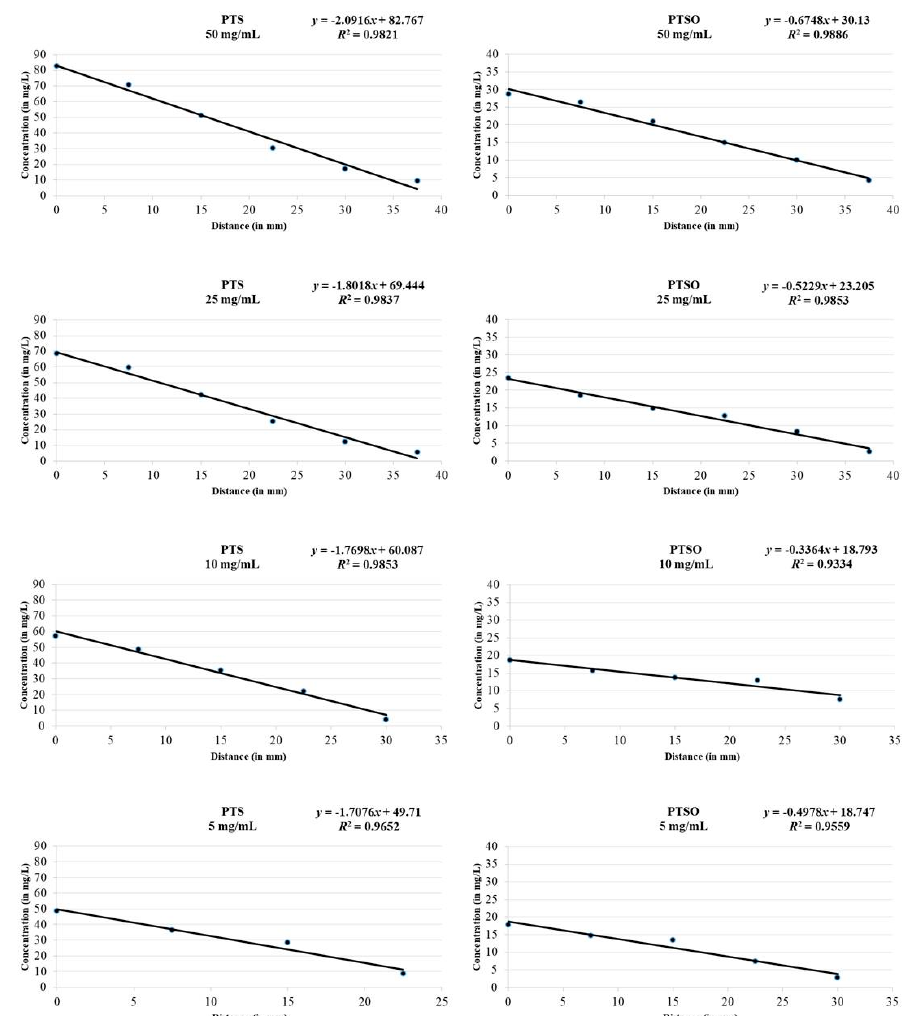
Figure 3. Relationship between the distance from the center of the Petri dish and the concentration reached via the gas phase at a defined point of the Mueller–Hinton medium for each concentration of PTS and PTSO deposited on the lid of the Petri dish. There is an inverse linear relationship between the distance to the center of the culture medium and the concentration reached via the gas phase at a given point.